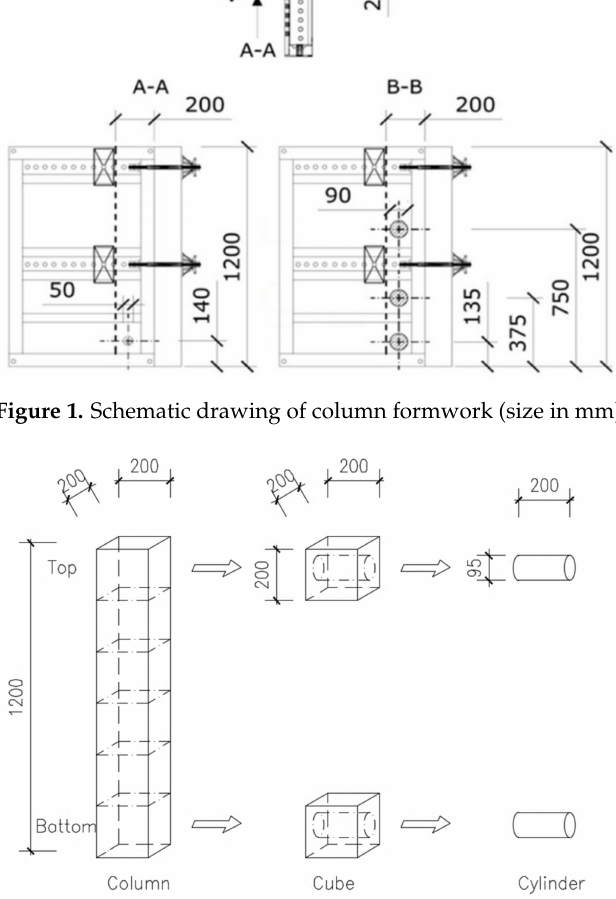
Figure 2. Schematic of cutting sections of columns to obtain individual cubes, and subsequent boreholes to obtain cylinders (size in